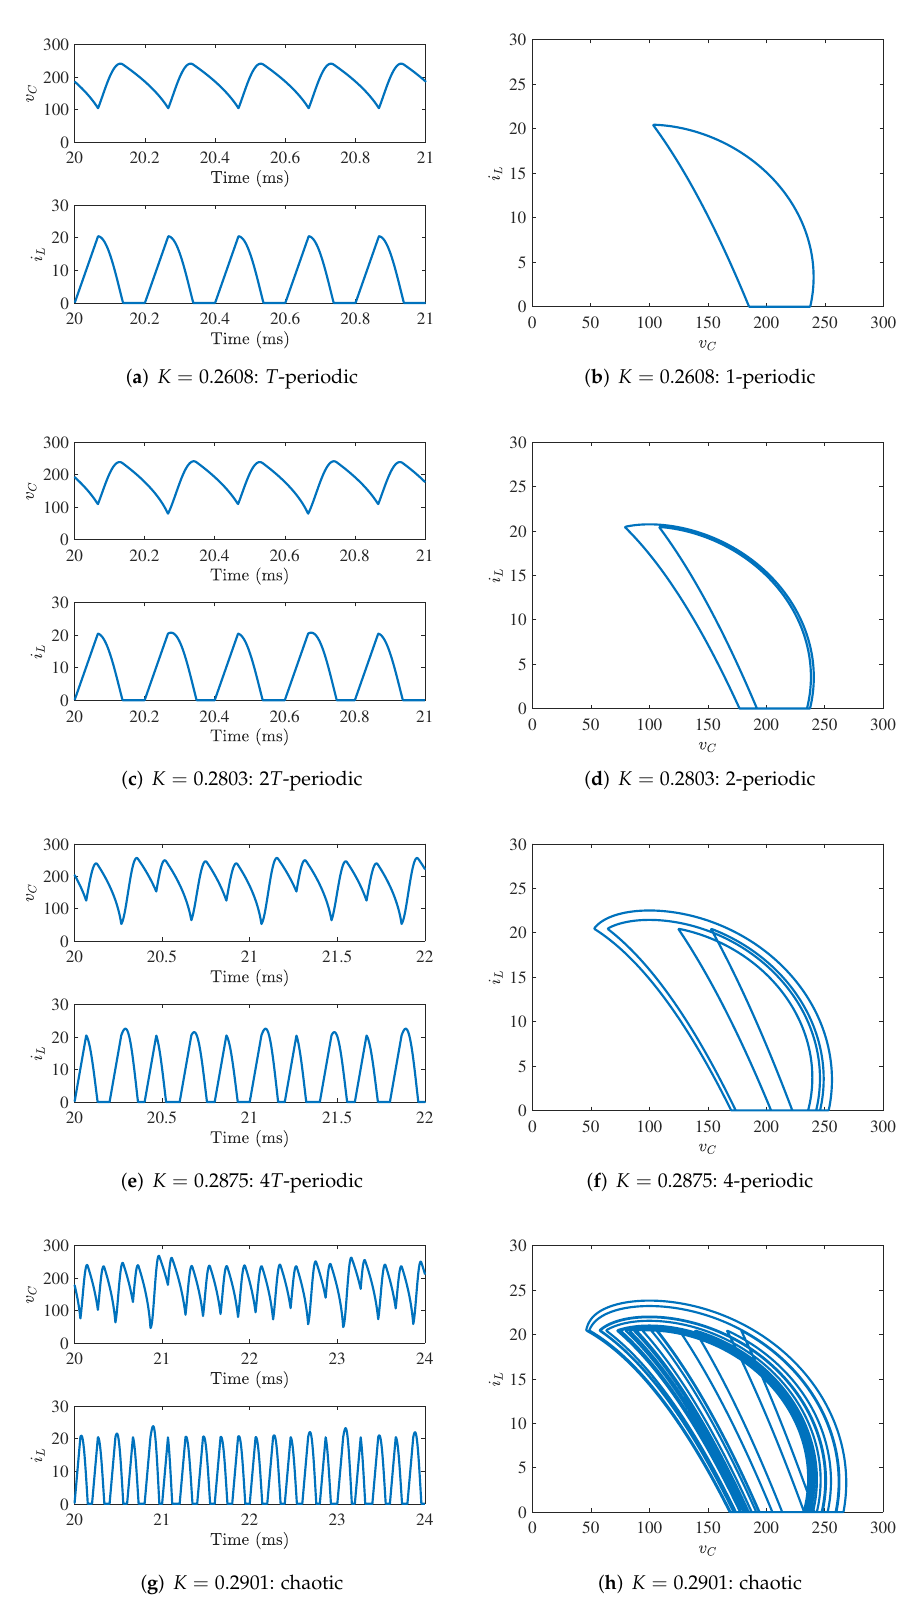
Figure 11. Time domain waveforms of the capacitor voltage and the inductor current for different dynamical behaviors obtained from the switched model of an open-loop-DCM-operated boost converter implemented in the PSIM ©